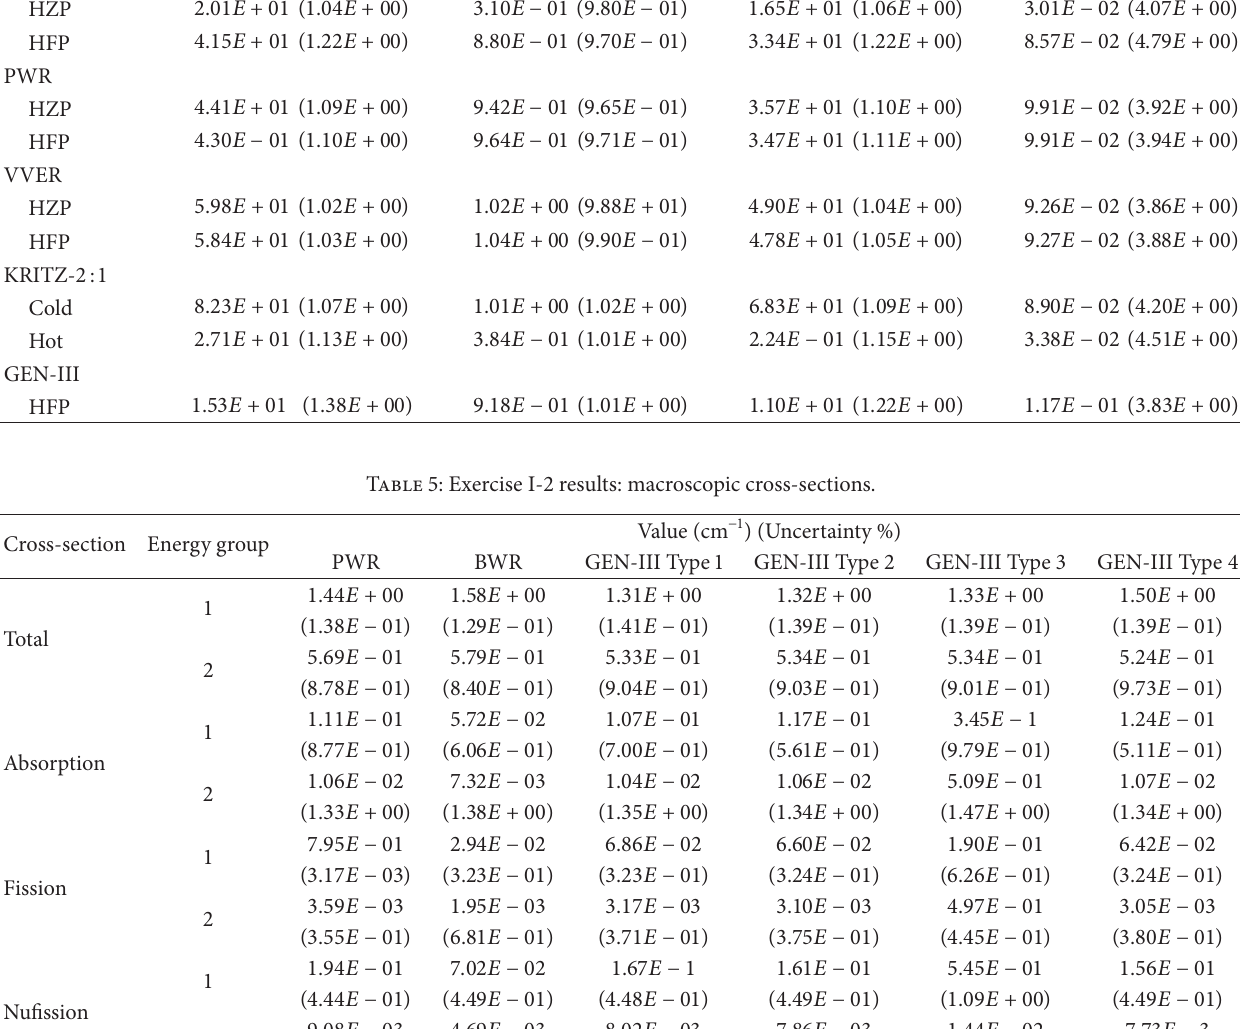
Table 4: Exercises I-1: one-group microscopic cross-sections.